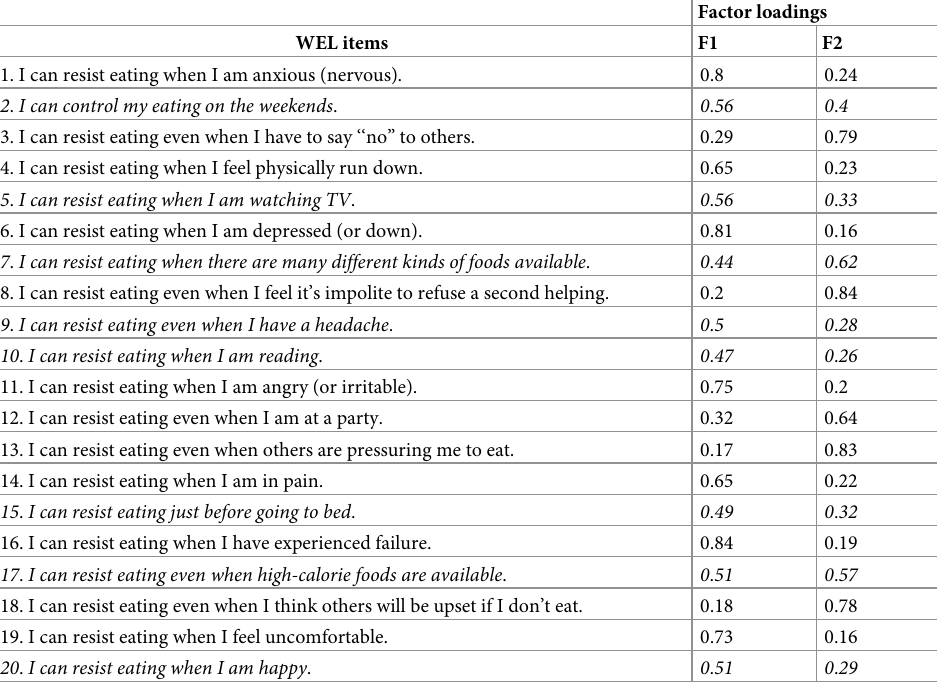
Table 3. Exploratory factor analysis results of the French version of the weight efficacy Life-Style questionnaire, carried out on the general population sample (n =